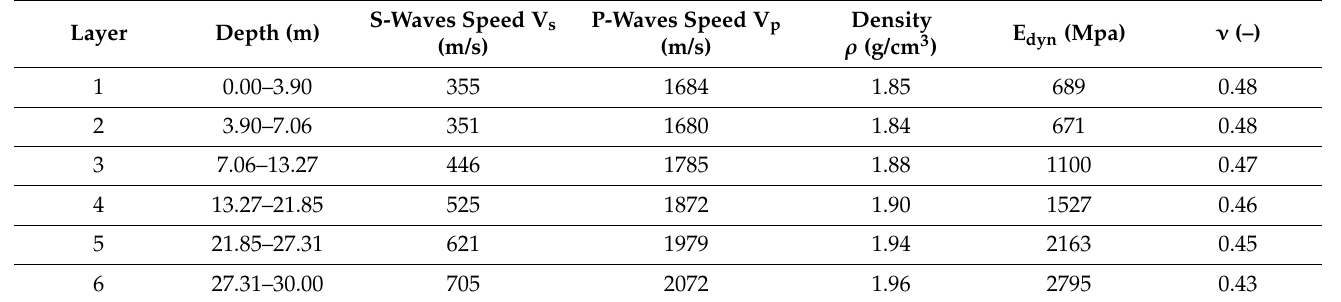
Table 3. Soilmechanicalparametersobtainedfromgeognosticsurveysandderivedfromtheoreticalcorrelations.